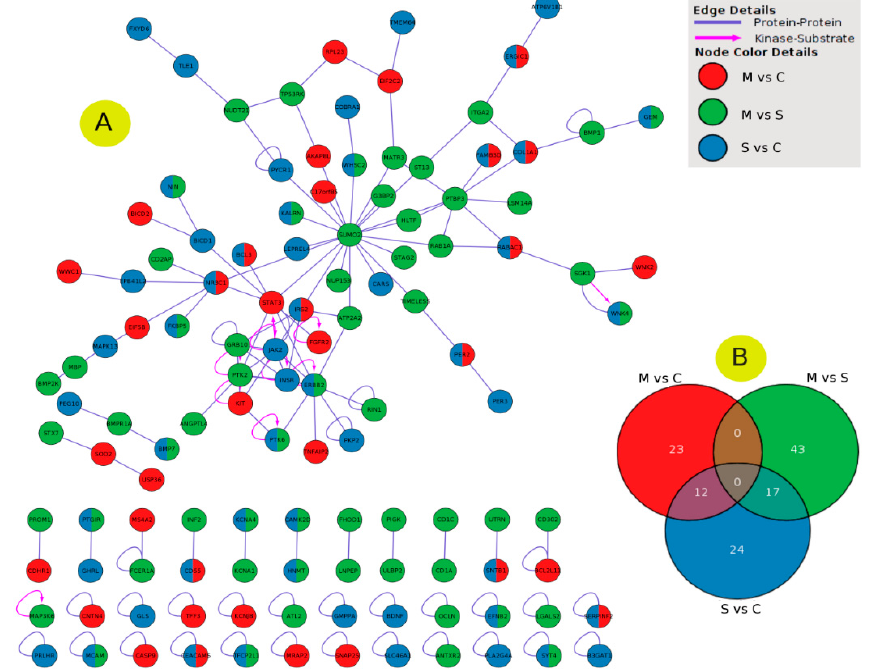
Figure 5. The PPI networks for DEGs differentiated in the three gene sets using Protein Interaction Network Analysis for Multiple Sets (PINA4MS). ( A ) PPI network, ( B ) the number of intersected genes through moderate (M-vs-C), severe (S-vs-C), and moderate-to-severe (M-vs-S) asthma gene sets. The color and shape of the edge (link) is related to the type of interaction (protein–protein or kinase-substrate interaction), where looped edges suggest that DEGs have a self-gene correlation. The color of the node of DEGs is associated with its participation in the asthma profiles studied.